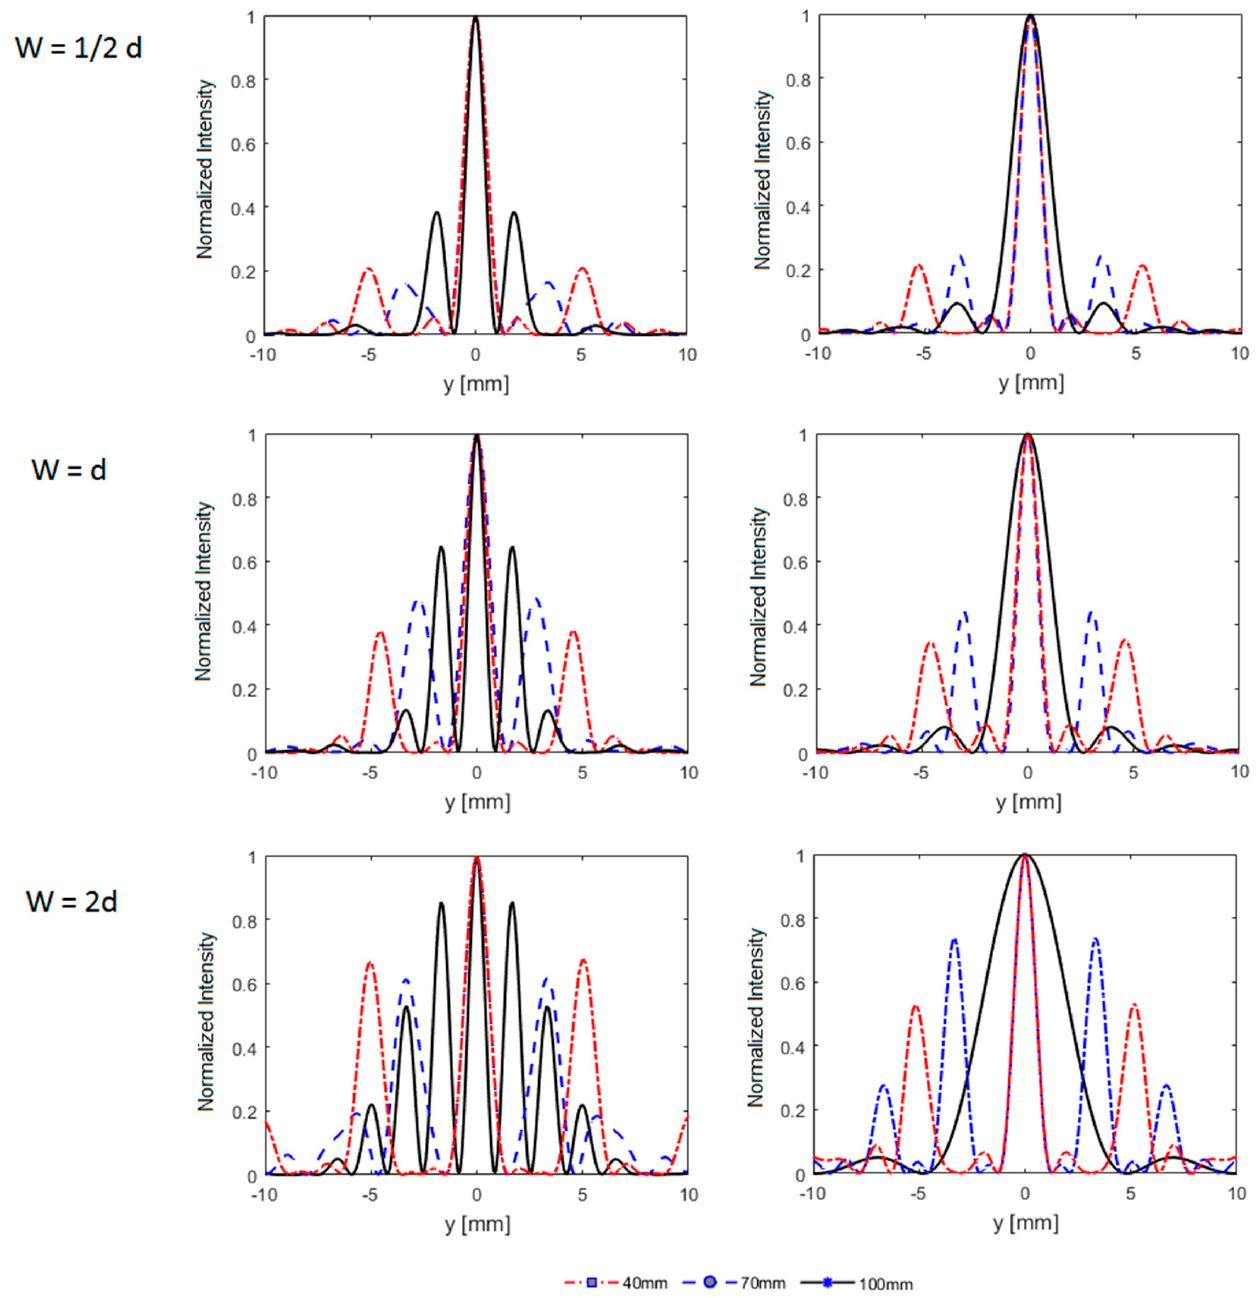
Figure 5. Intensity distribution in the focal plane for different rib phantoms (W = 1/2d, W = d, W = 2d) where W is the width of the ribs and d is the edge–edge spacing between them, when the phantoms are positioned at a depth of 40 mm (red dotted line), 70 mm (blue dashed line), and 100 mm (black solid line) from the center of the array, and when the beam axis passes through one of the ribs ( left column ) and intercostal space ( right column